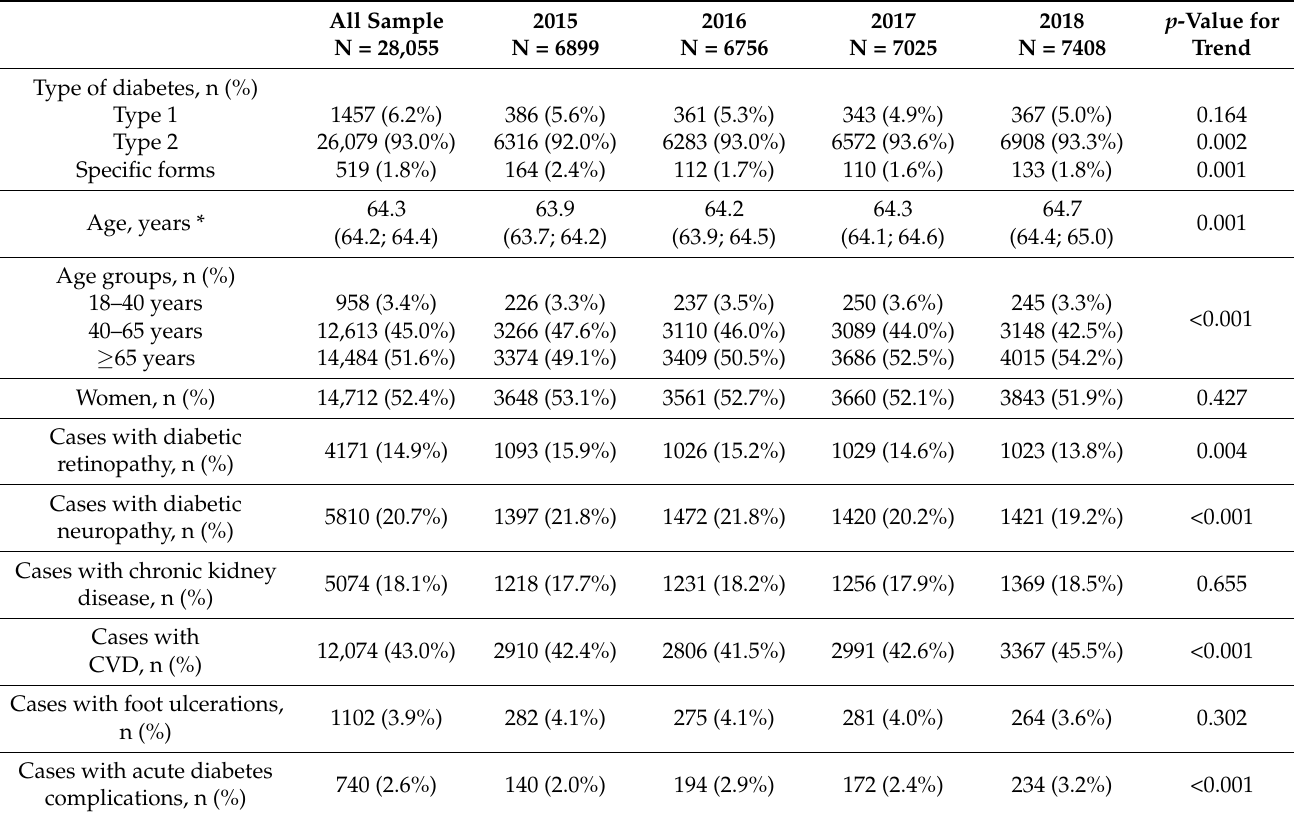
Table 1. Description of the study sample (episodes of